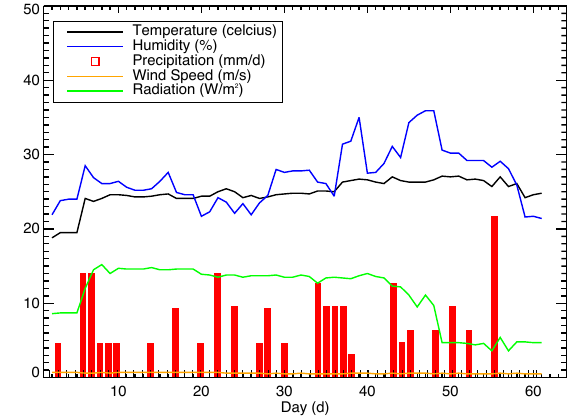
Fig. 2. Daily meteorological measurements and applied precipita- tion in UNESCO-IHE laboratory for December and